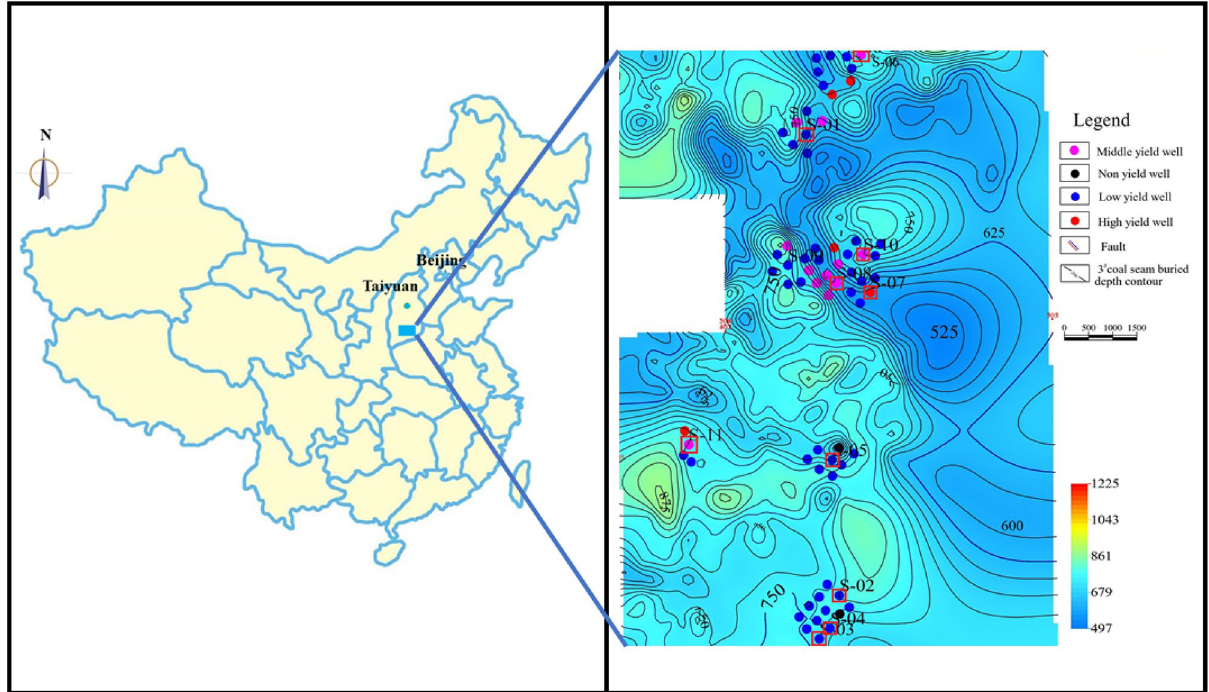
Figure 1. The average daily gas production in the study area. Map was drawn by DF-GVision4.0. URL link: http:// www. gdfoil. com/ Index/ lists/ catid/ 16.